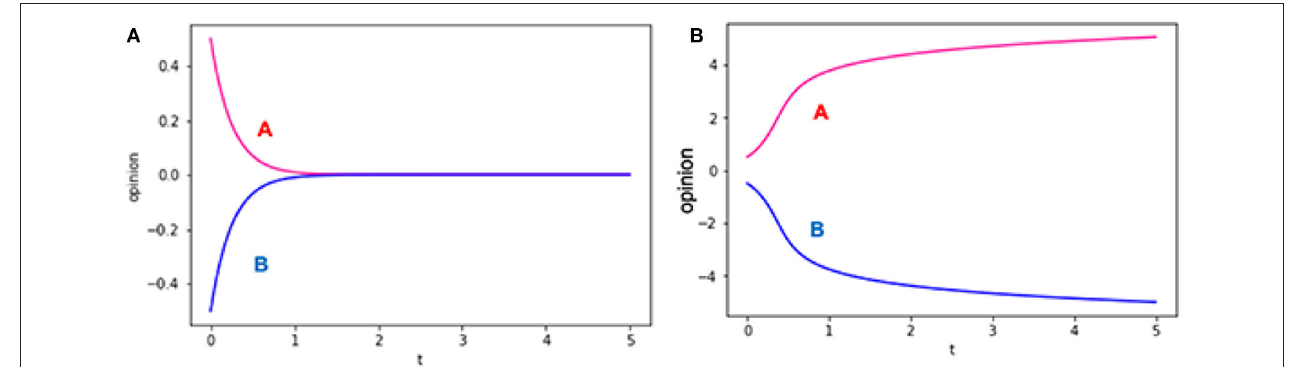
FIGURE 1 | Calculation result for N = 2. (A) D AB > 0 and D BA > 0. (B) D AB < 0 and D BA < 0.